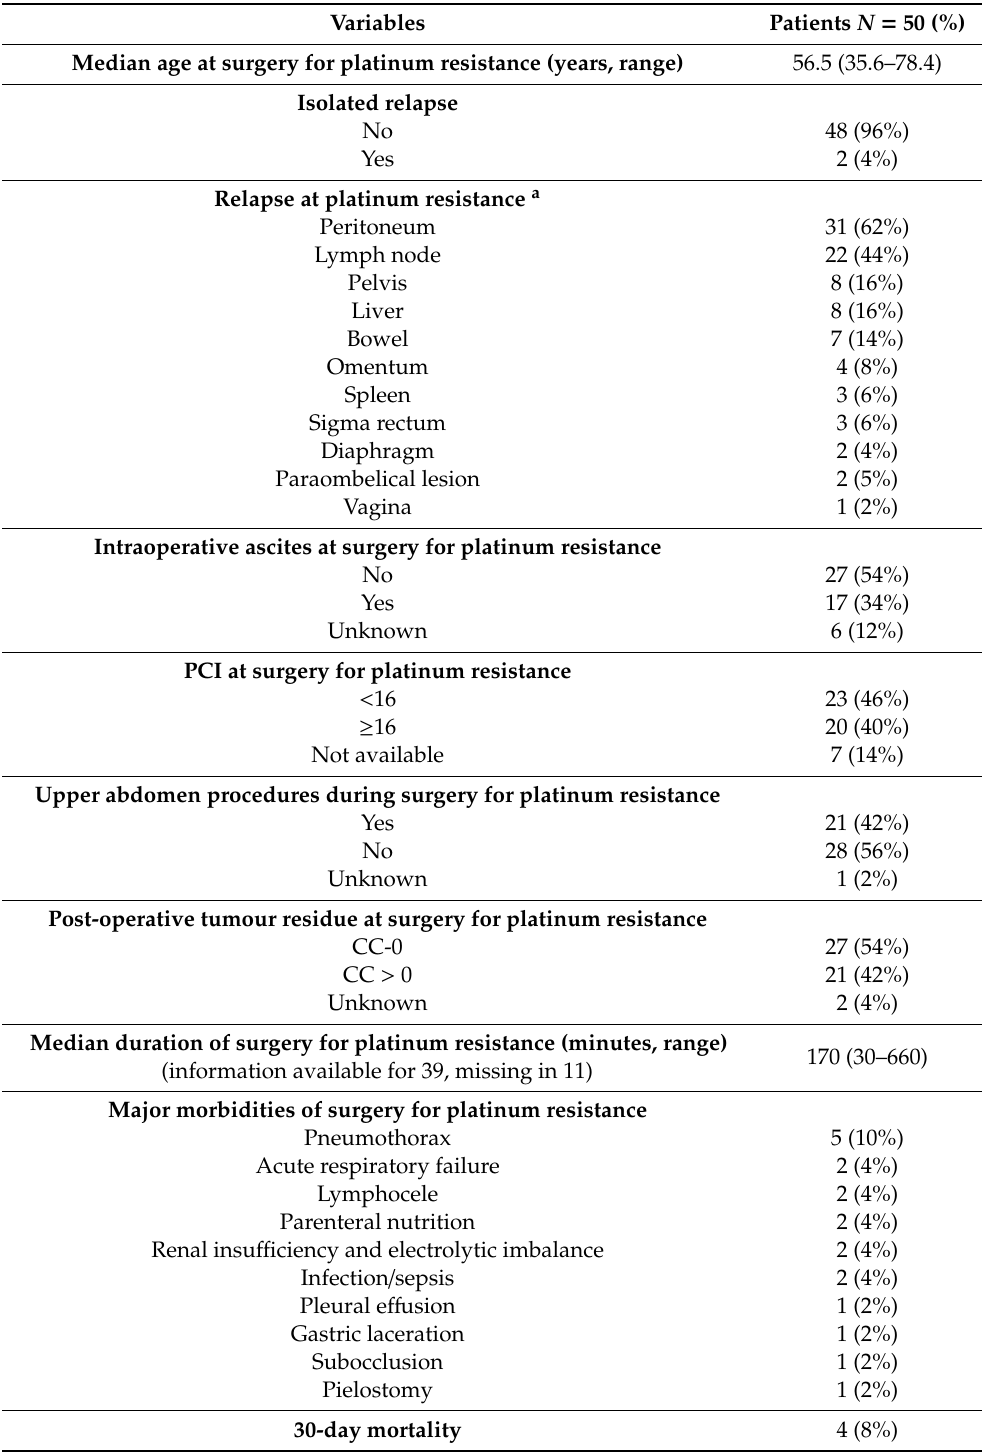
Table 2. Patient characteristics at platinum resistance and surgical